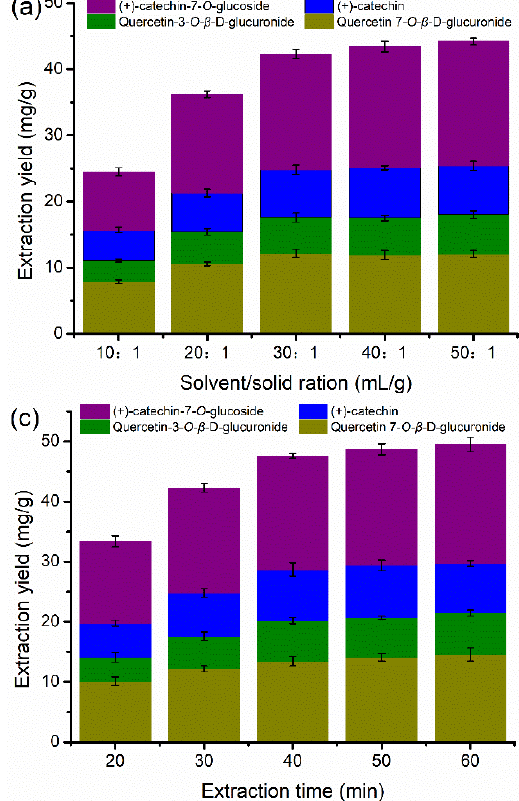
Figure 4. Conditions for extraction and yield of flavonoids in the 70 v / v % DES-3 ultrasonic bath. ( a ) effect of solvent/solid ratio at ultrasonic power of 300 W for 30 min. ( b ) Effect of ultrasonic power with solvent/solid ratio in 30/1 mL/g for 30 min, and ( c ) effect of extraction time with solvent/solid ratio in 30/1 mL/g and at ultrasonic power of 300 W.